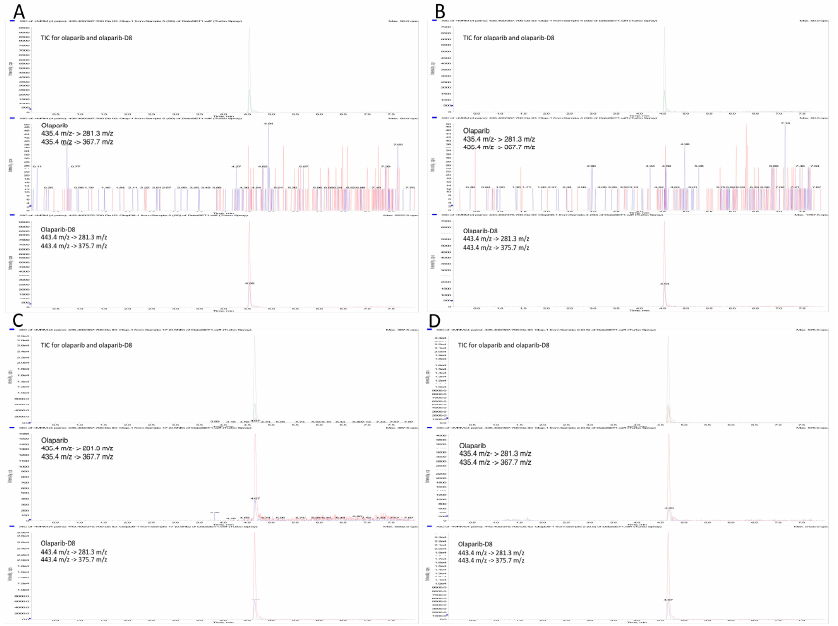
Figure 3. Representative chromatograms of validation samples: ( A ) Blank nuclei, ( B ) blank Cytoplasm, ( C ) nuclei extract at LOQ (0.42 ng/mL), and ( D ) cytoplasmic extract at LOQ (0.10 ng/mL). In all figures from the top: Total ion Chromatogram (MRM signals are overlayed), Ola extraction, and Ola-d8 extraction.